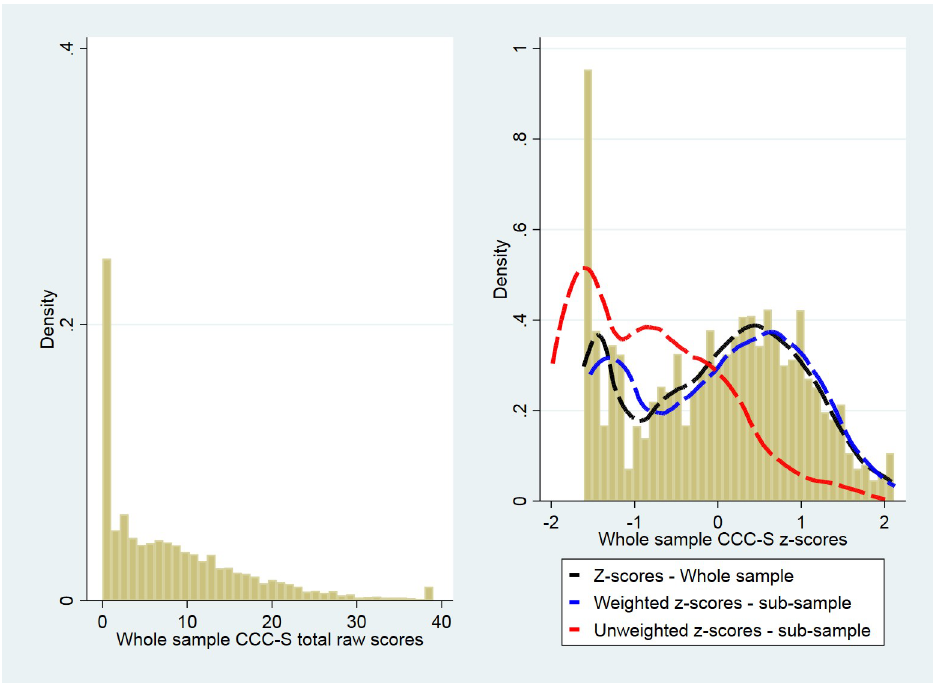
Fig 1. Histograms for raw and standard scores of the CCC-S. Histograms for the raw values (left) and the standard scores (right) of the CCC-S questionnaire, based on the entire sample (n = 6,459). Dashed lines in the right panel depict the Kernel density of the z-scores obtained from the entire sample of 6,459 children (black), and the weighted (blue) and unweighted (red) Kernel densities of the z-scores based on the intensively assessed sample of 528 children.